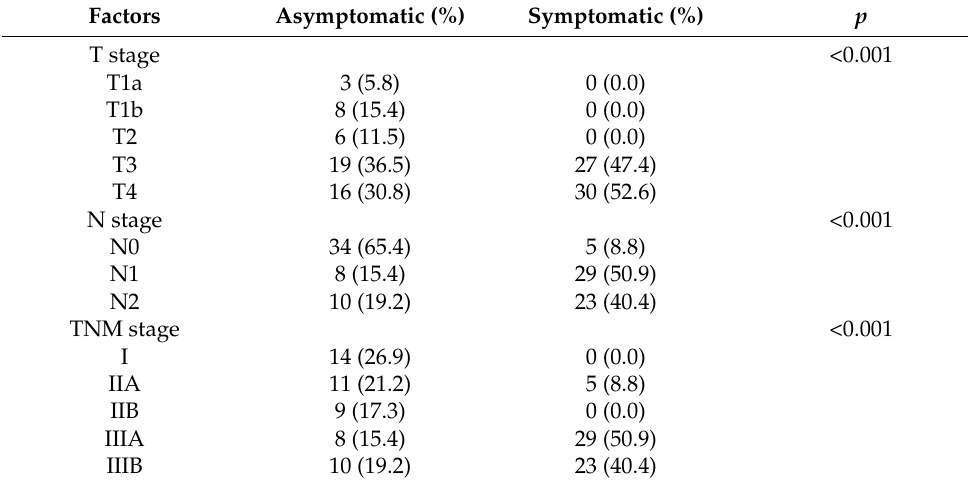
Table 6. Correlations between symptoms and tumor stages ( n =